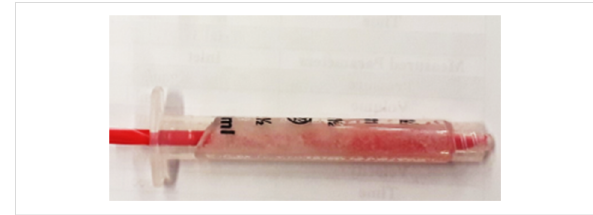
Figure 4: Facile syringe-tube assembly used in fabricating the hydrogel channels.